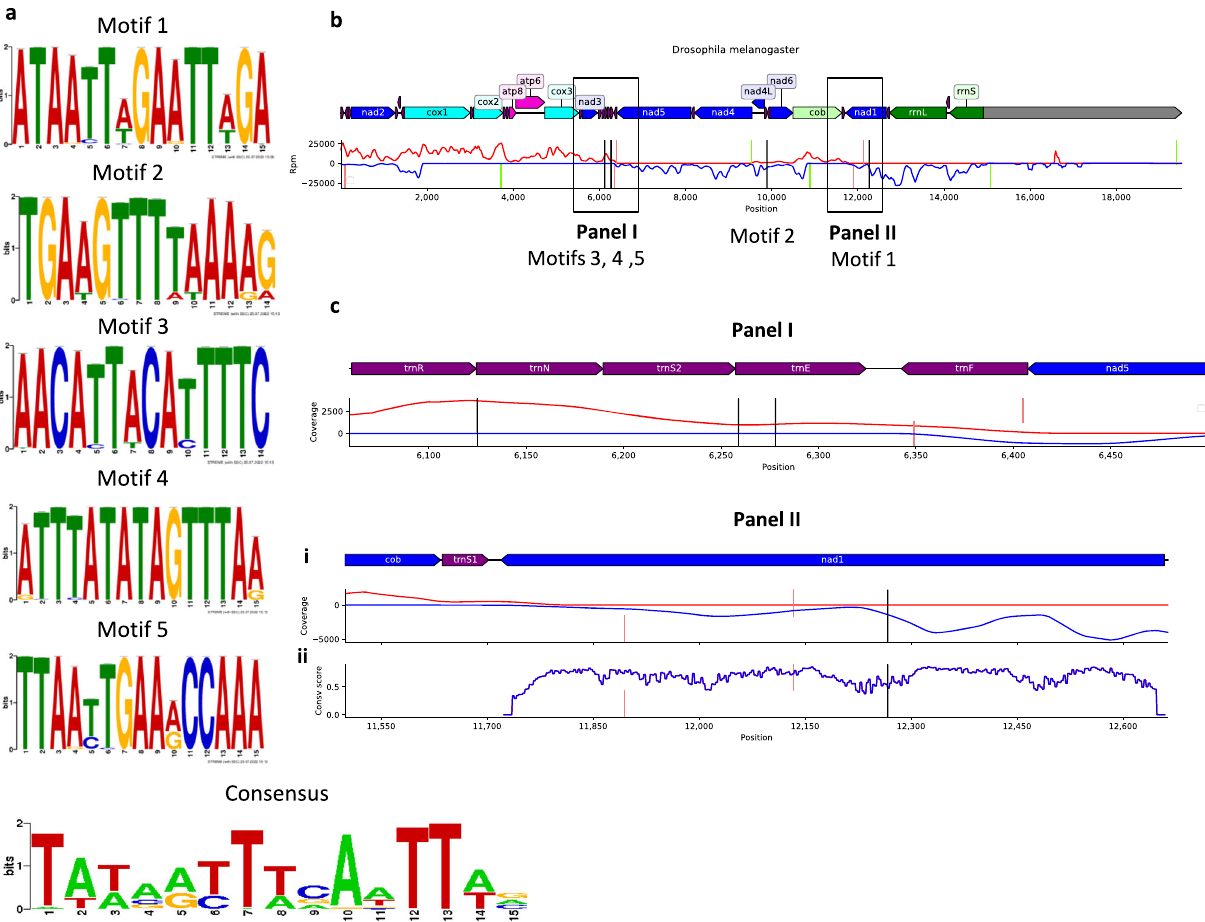
Fig. 6 Different strand junction loci contain conserved sequence motifs that are enriched in species with alternating gene block organization. a Sequence logo plots of each of the fi ve motifs that are signi fi cantly enriched in alternating gene block organization species, and of their consensus sequence. b Coverage plot of an example D. melanogaster PRO-seq sample. The forward strand coverage is shown in red and the reverse strand coverage in blue. Motifs are marked as vertical black lines, and transcription initiations and terminations are marked as vertical green and red lines, respectively. The motifs ’ numbering appears below the vertical black lines. c Zoomed-in coverage plots showing the positions of motifs 3, 4, and 5 (Panel I) and motif 3 (Panel II). The bottom plot within Panel II (plot ii) shows the protein conservation score per codon of ND1 . See also Supplementary Data S11 for raw data (https:// fi